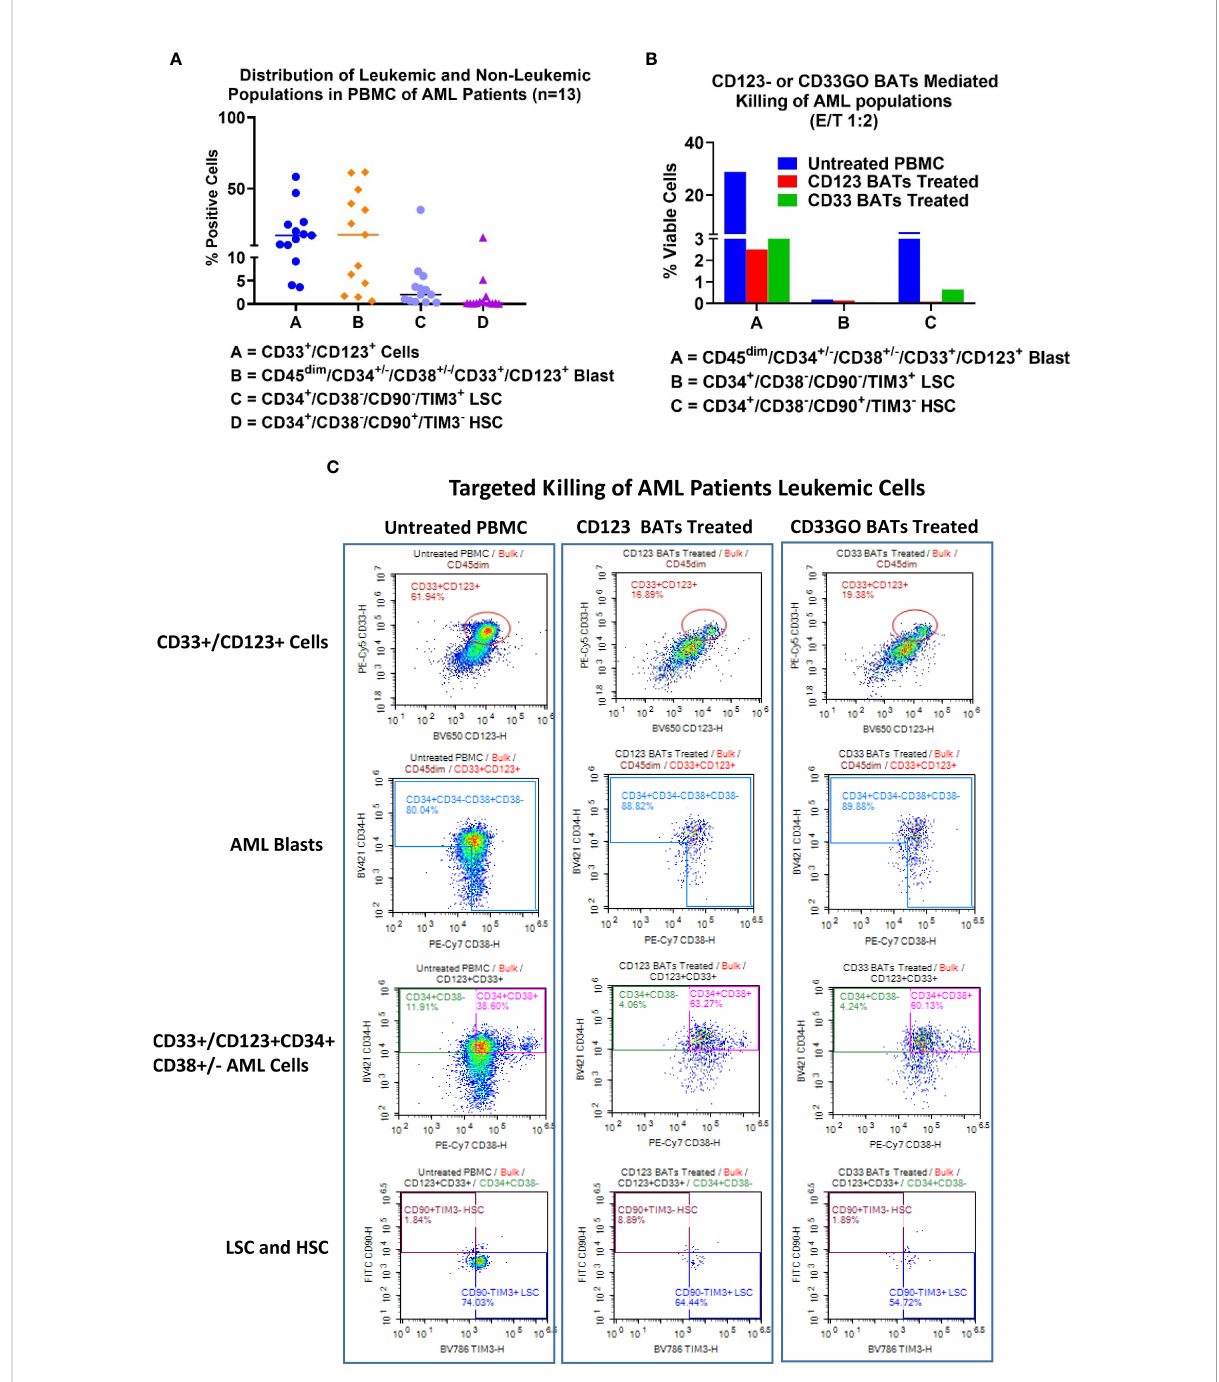
FIGURE 4 Cytotoxicity of AML patient derived PBMC. Cryopreserved PBMC from 13 AML patients from UVA were used as targets and CD33GO- or CD123 BATs as effectors at 1:1 E:T ratio for fl ow-based cytotoxicity assay. (A) Proportions of Blast and LSC in patient derived samples. Data show the proportions of CD33 and CD123, CD34+/CD38-, CD34+/CD33+ (Blasts), LSC and HSC in the primary AMLs samples. (B) Shows the targeted killing of AML blasts, AML leukemic stem cells and hematopoietic stem cells by CD33GO- and CD123 BATs compared to untreated PBMC from a patient. (C) Shows an examples of fl ow cytometry analysis of untreated (left panel), CD123 BATs (middle panel) and CD33GO BATs treated (right Panel) peripheral blood mononuclear cells (PBMC) sample (unique ID# 8500). Lower two plots of each panel show percentage of blasts, CD33+/CD123+ cells, HSC and LSC populations in untreated and BATs treated